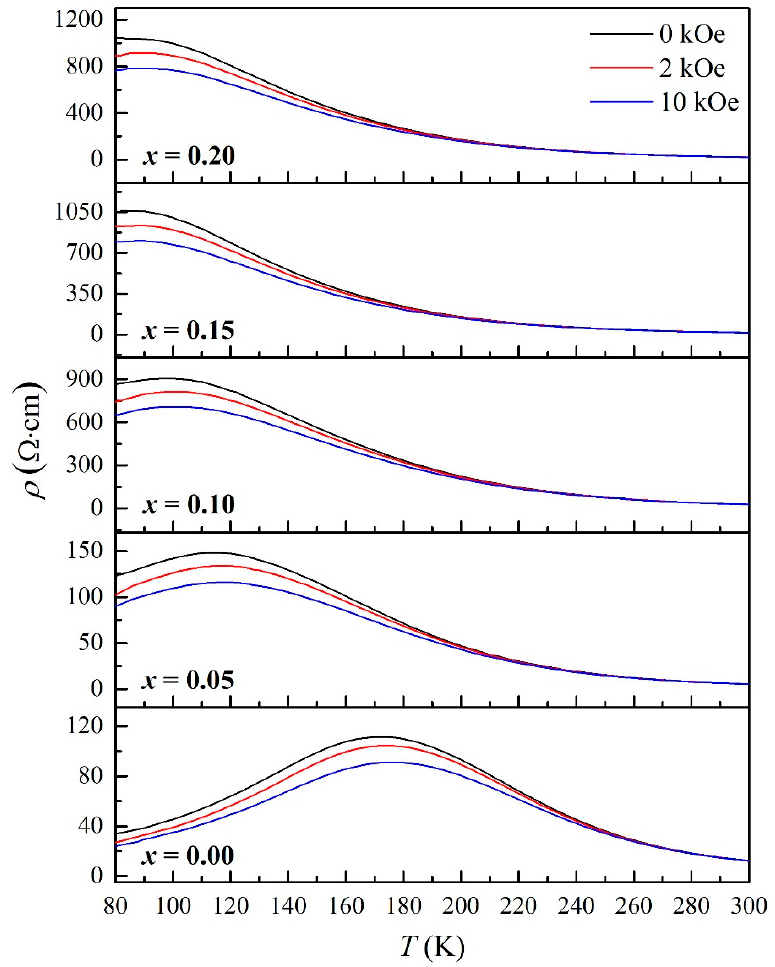
Figure 4. Temperature dependence of the resistivity at various fields for the pure LCMO and its composites.